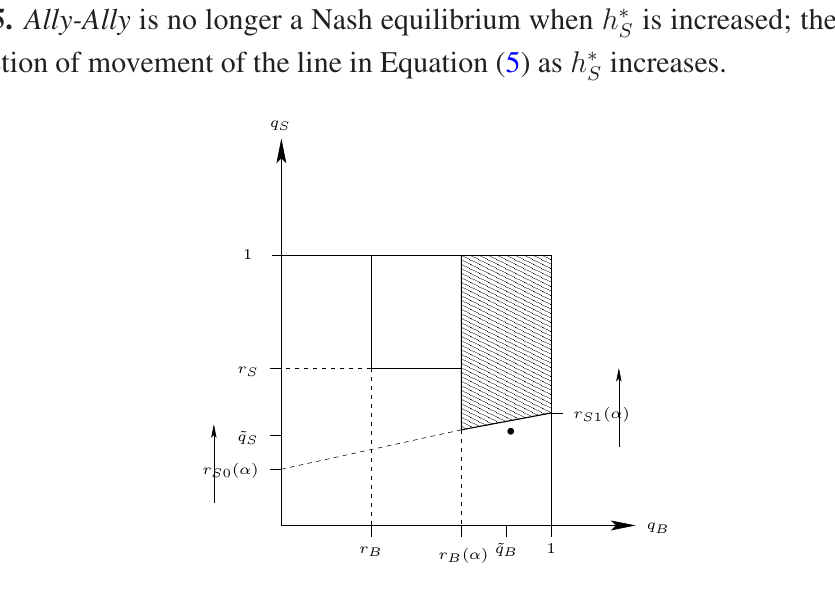
the direction of movement of the line in Equation (5) as h ∗